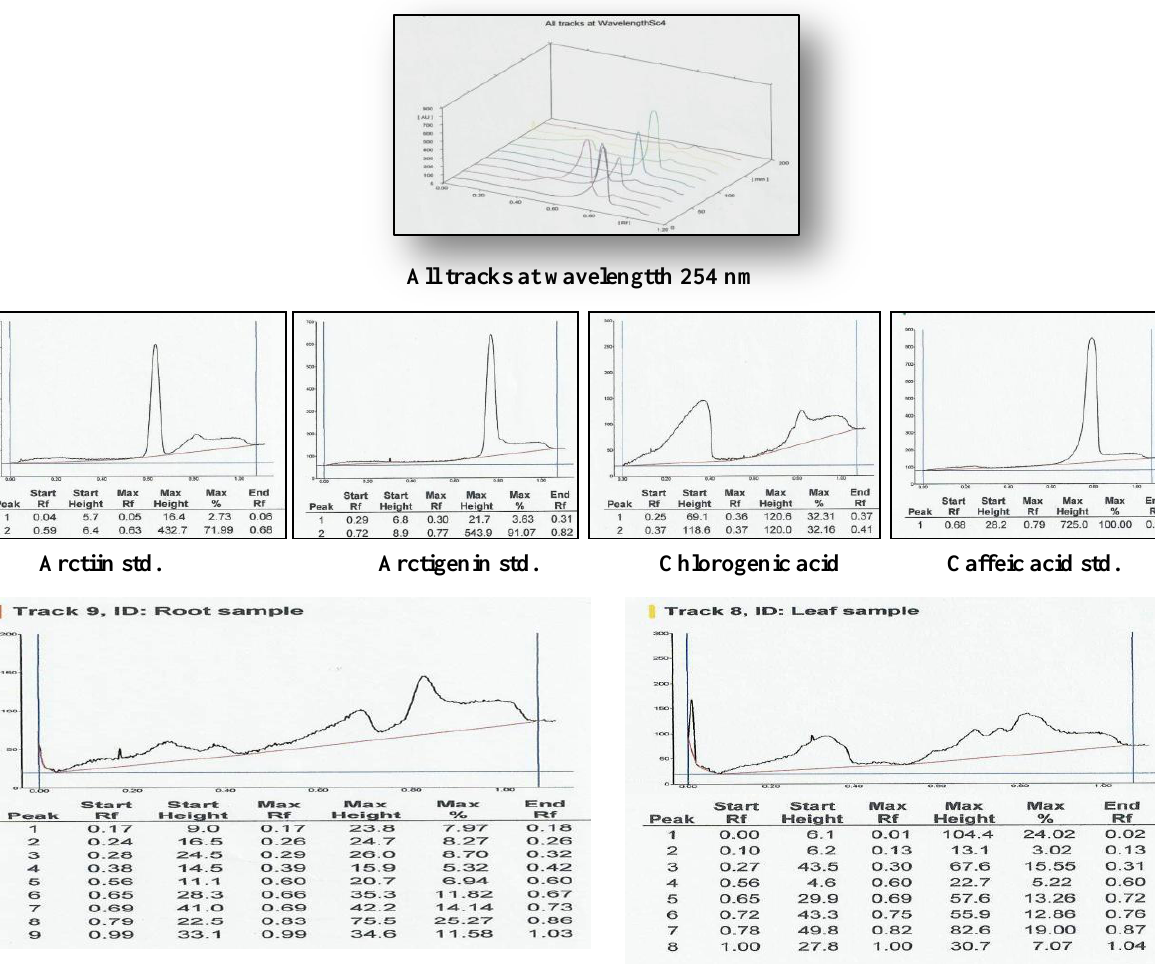
Figure 4: HPTLC analysis of methanolic extract with reference